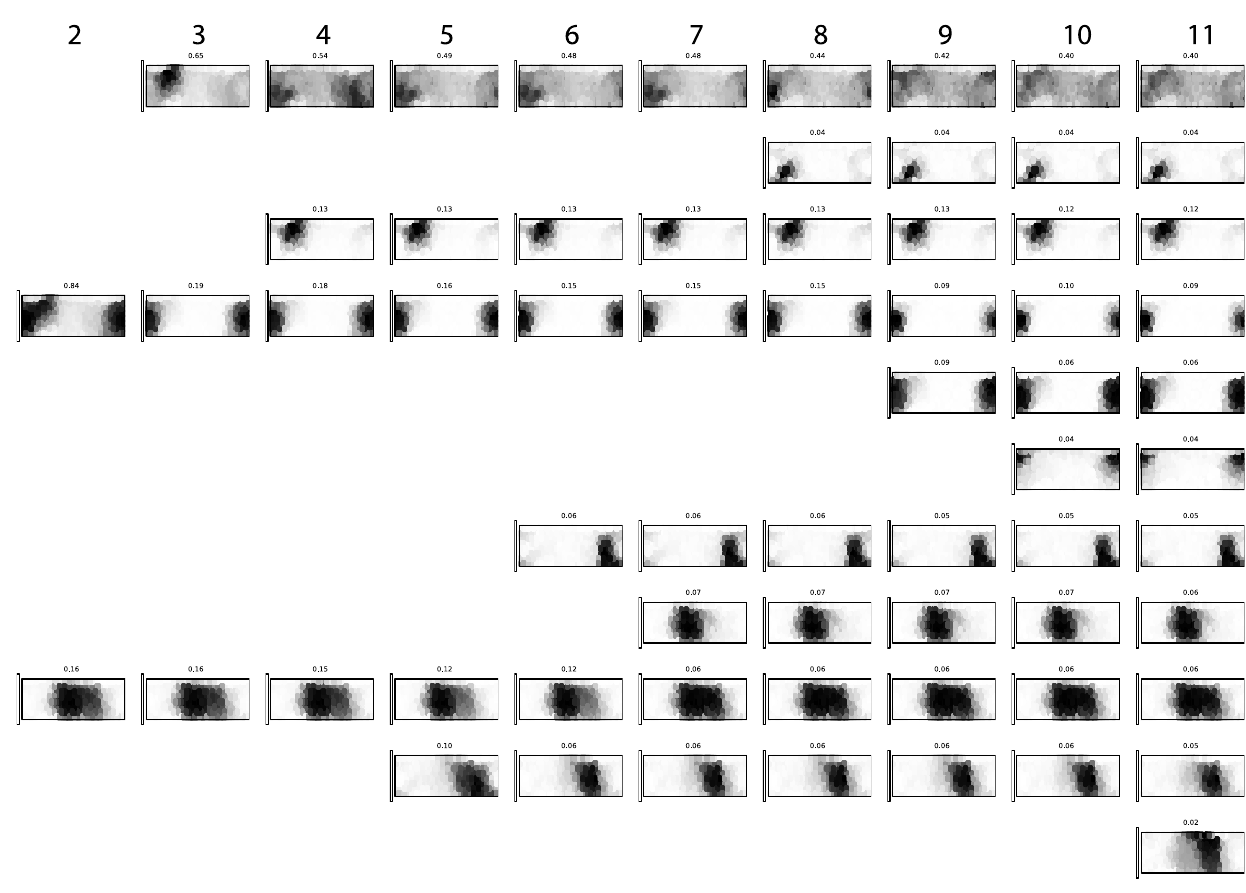
Figure 4. k -means clustering hierarchy on chromatic response vectors, after projecting by a factor of the exponential similarity matrix for color chips.